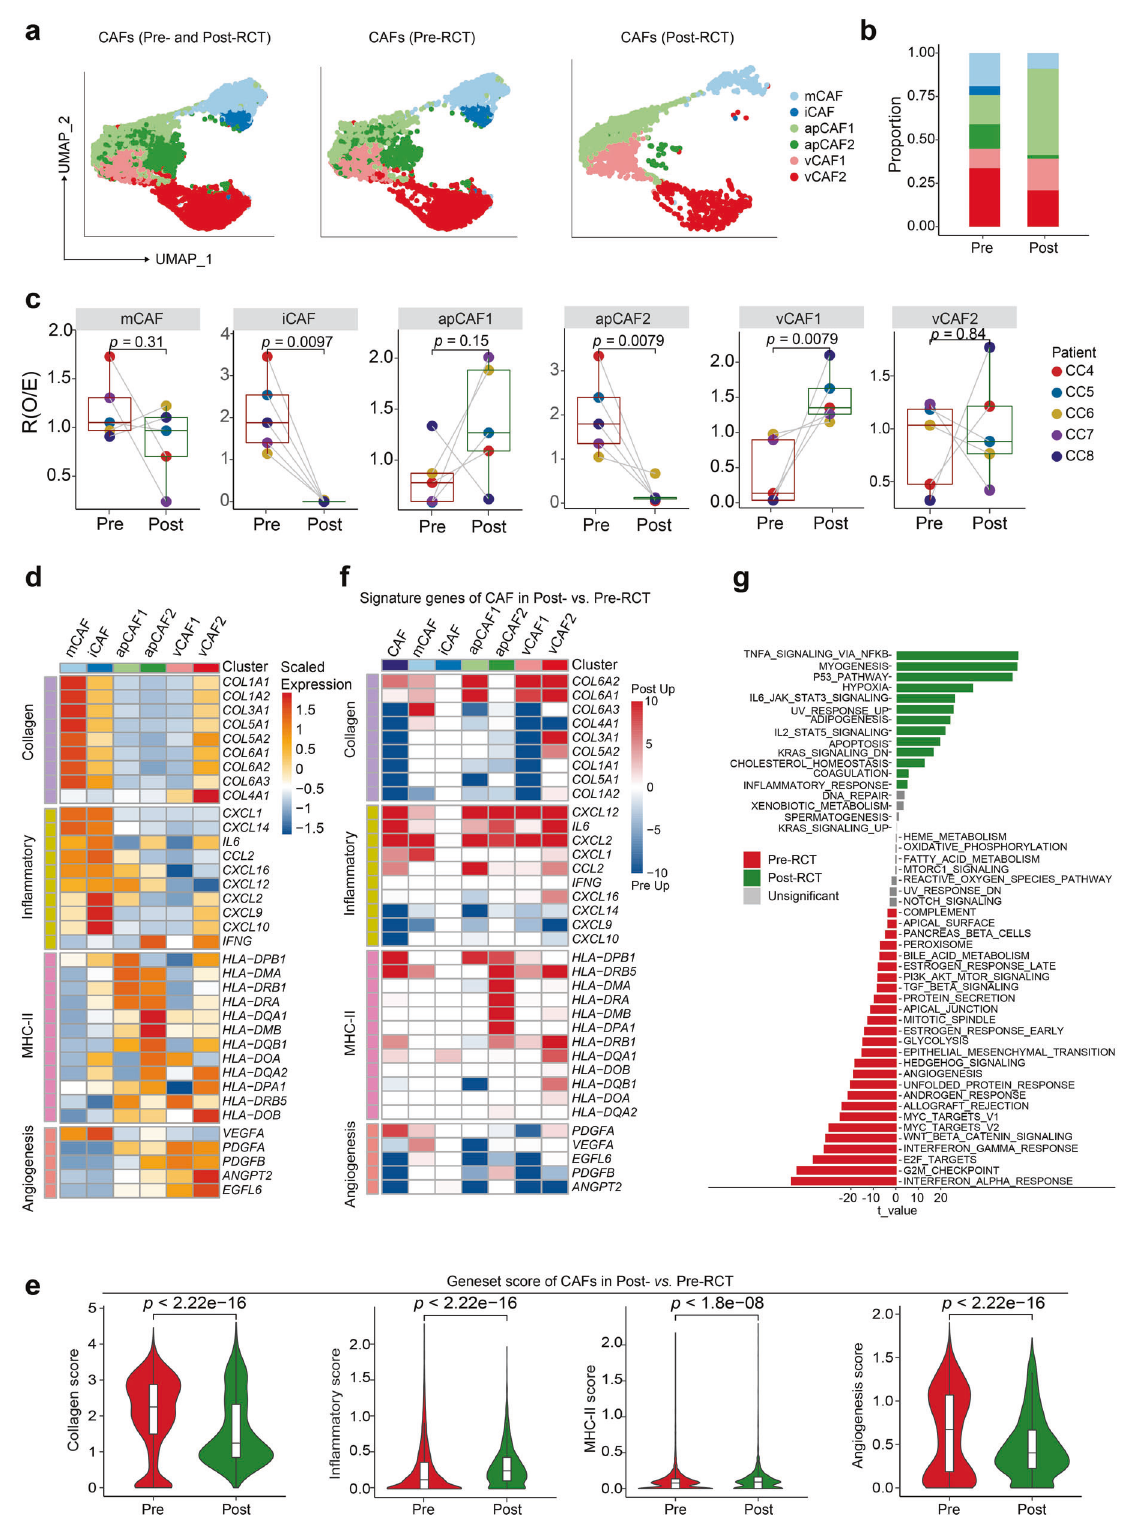
potentially important novel players in the post-RCT ecosystem. We show that RCT leaves behind a population of epithelial cells with upregulated expression of genes encoding MHC class